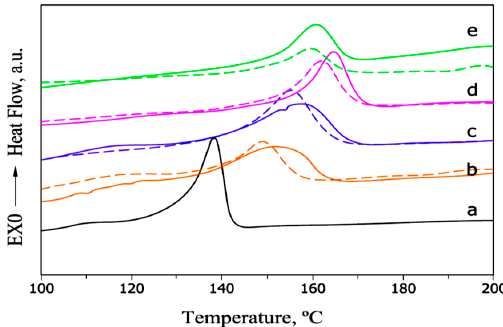
Figure 9. DSC cooling thermograms of neat PVA and PVA-HNT composite films with different HNT